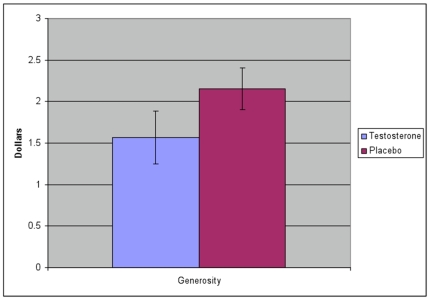
Generosity (UG offer - UG punishment threshold) by participants on placebo was $2.15 compared to $1.57 when the same individuals were given Androgel®, a 27% reduction (p = .035; bars in graph are SEs).More participants on Androgel® relative to placebo showed negative generosity by setting a punishment threshold above than their own offer to DM2 (9.6% vs. 2.9%).